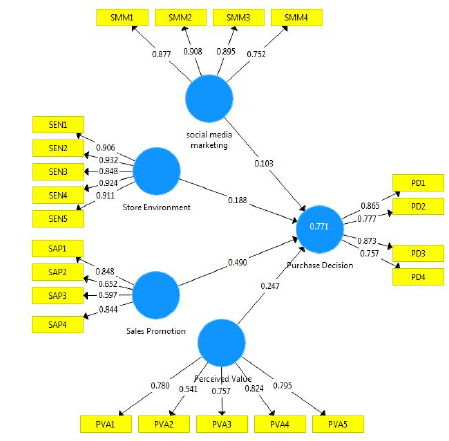
Fig. 2. The results of convergent validity